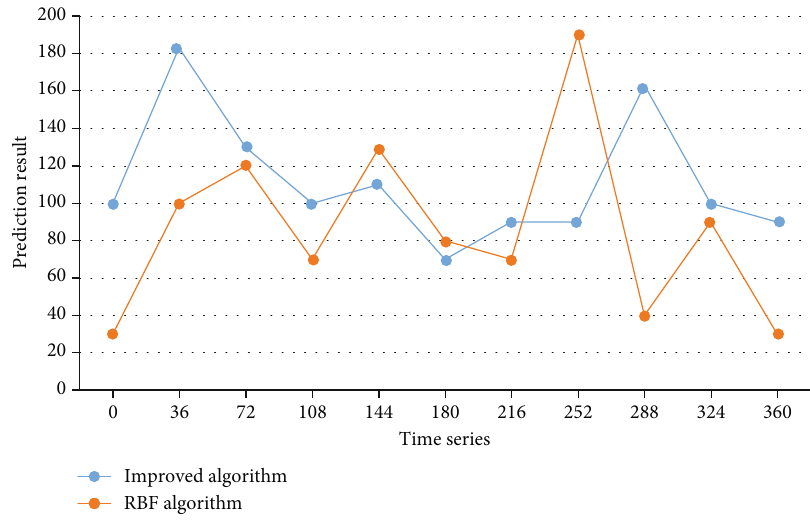
Figure 8: Comparison chart of prediction e ff